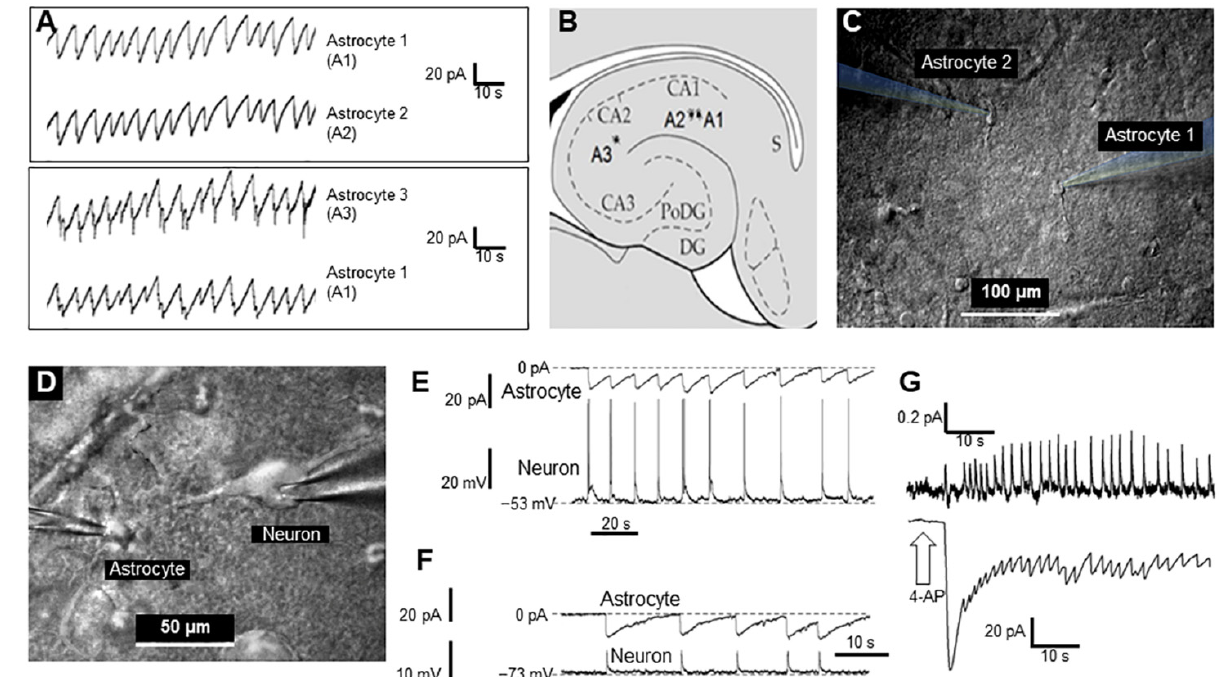
Figure 1. Synchronous activity of two astrocytes and neurons in the CA1 zone of the rat hippocampus after short-term application of 2 mM 4-AP: ( A ). Currents recorded from hippocampal astrocytes 1 and 2 (top panel) and 1 and 3 (bottom panel). ( B ). Sketch of the hippocampus with schematic positions of the astrocytes that were monitored in pairs. ( C ). Infrared image of two astrocytes with electrodes for patch-clamp. ( D ). Infrared image of a neuron and an astrocyte with electrodes attached for patch-clamp. ( E , F ). Current and voltage recording from an astrocyte and neuron, respectively. Panel E shows the neuron action potentials (APs), and the synchronous changes in the astrocyte’s membrane potential (Panel F) shows the excitatory postsynaptic potentials (EPSPs) of the neuron, observed during artificial hyperpolarization of the neuron, and synchronous changes in the membrane potential of an astrocyte. ( G ). Extracellular recording of neuron firing and current changes recorded from an astrocyte (top and bottom, respectively) elicited by 4-AP.